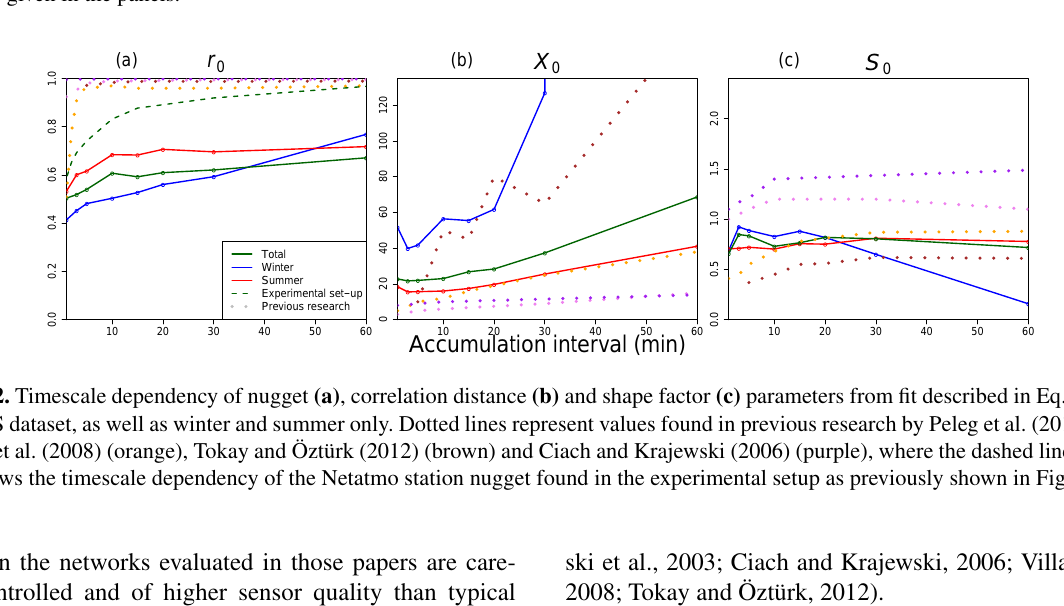
Figure 11. Correlograms of all stations after filtering at various accumulation intervals for winter (top panels) and summer (bottom panels). The red and blue areas represent the interquartile range of the Netatmo stations and non-Netatmo stations, respectively. The areas are constructed with a moving window of width 5km. The scatter plots are fitted with the exponential relation of Eq. (2), the parameters of which are given in the panels.